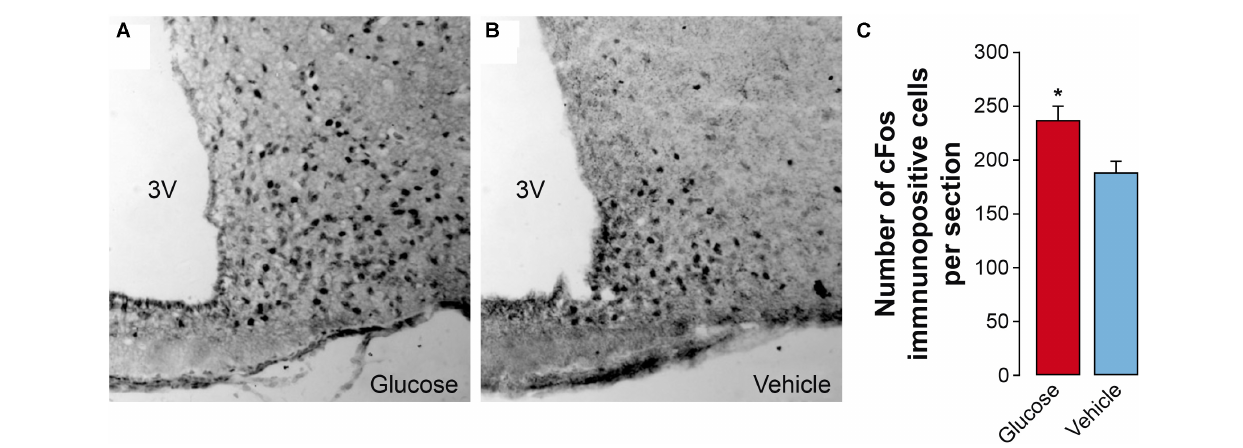
FIGURE 7 | Effect of glucose administration on hypothalamic c-fos expression. (A,B) Representative immunohistochemical sections showing c-Fos immunoreactive cells in the arcuate nucleus (ARC) of mice treated with glucose (A) or saline ( B , 0.9% NaCl). (C) Quantification of the number of c-Fos immunopositive cells in the arcuate nucleus obtained from sections similar to those shown in panels (A,B) (mean + SEM). A total of 8 sections per treatment were used. ∗ p < 0.05, Student’s t test. 3V, third